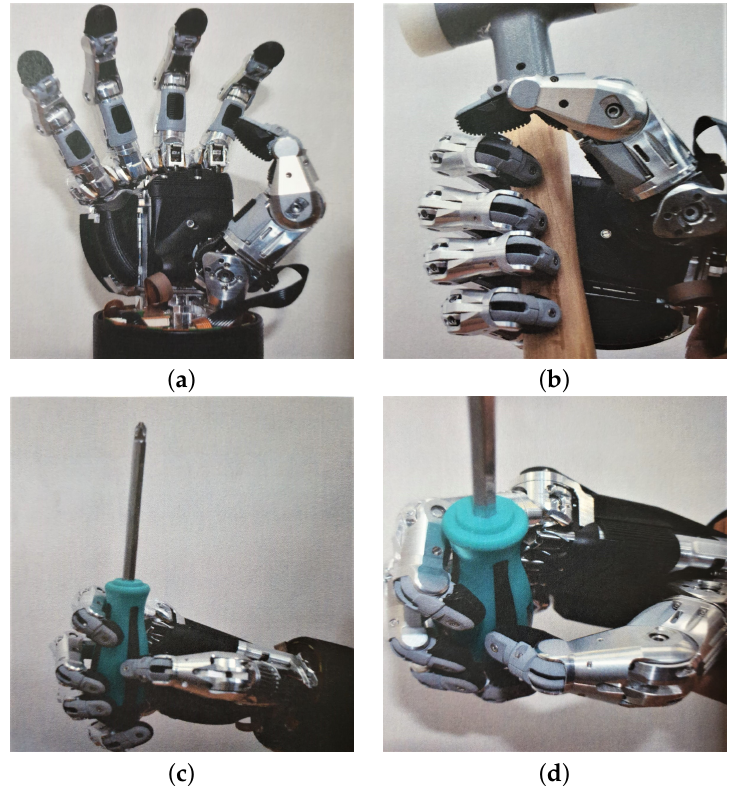
Figure 4. Grasping illustration with schunk SVH 5-finger gripper, from top-left to bottom-right: ( a ) empty gripper, ( b ) hammer grasping with 4 contact points, ( c ) screwdriver grasping, ( d ) screw- driver tilted view with focus on contact points.